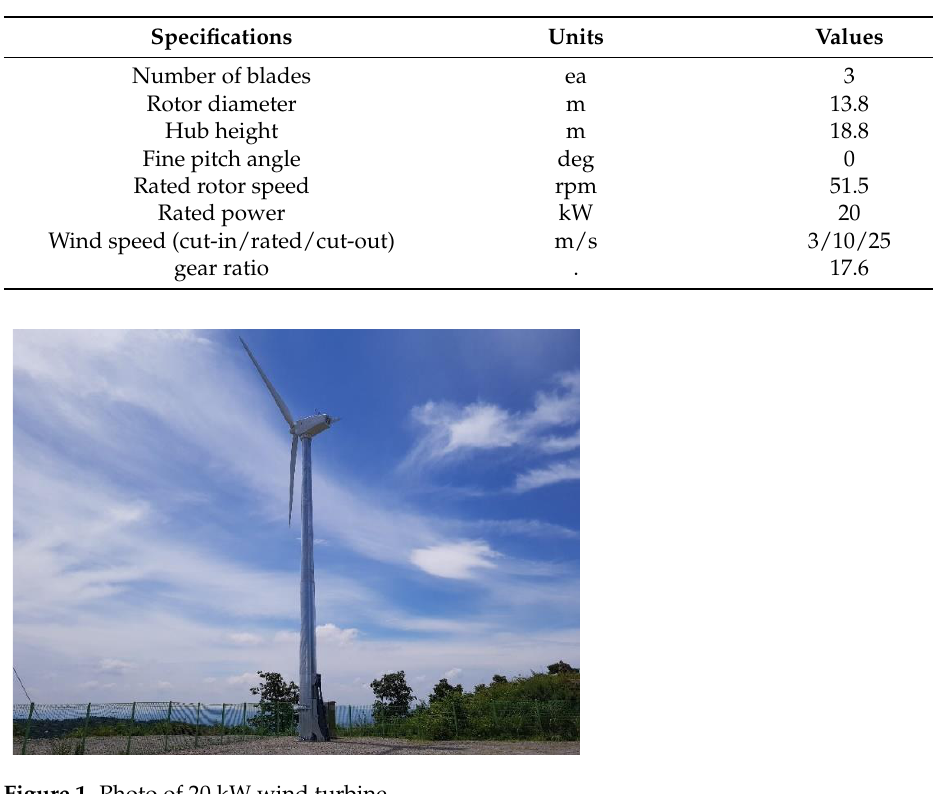
Table 1. Specifications of the target wind turbine.